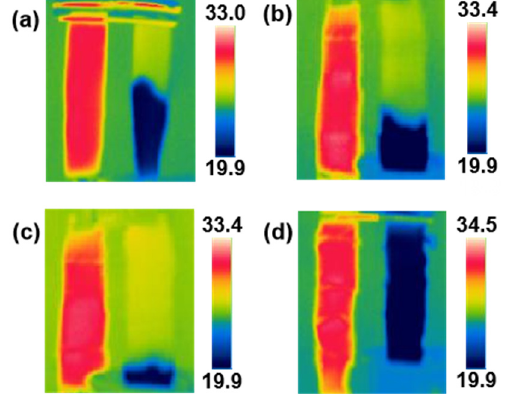
Figure 9. Infrared imaging photos of CFs ( a ), PPy@CFs ( b ), PB@CFs ( c ), and PB/PPy@CFs ( d ) before and after wetting.